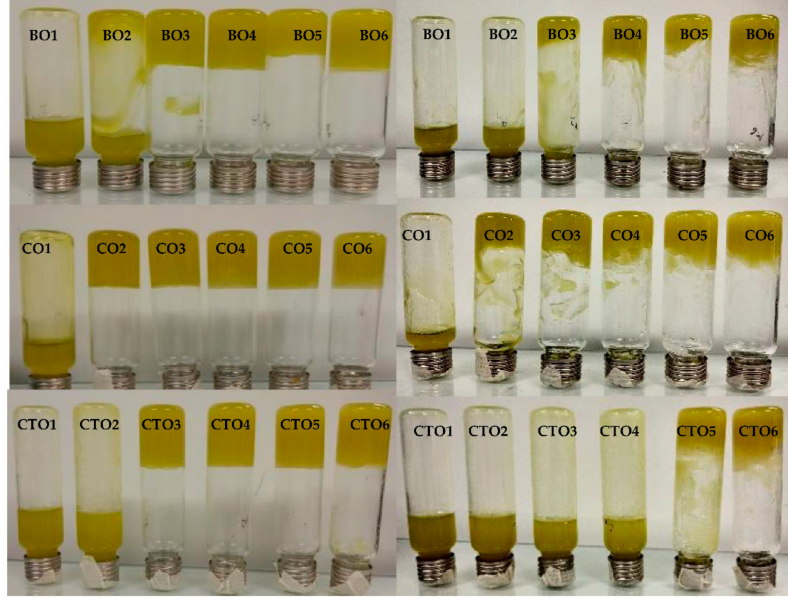
Figure 1. Inversion tests for beeswax ( top ), candelilla ( middle ) and carnauba ( bottom ) organogels. Samples are shown after production ( left ) and after two months of storage ( right